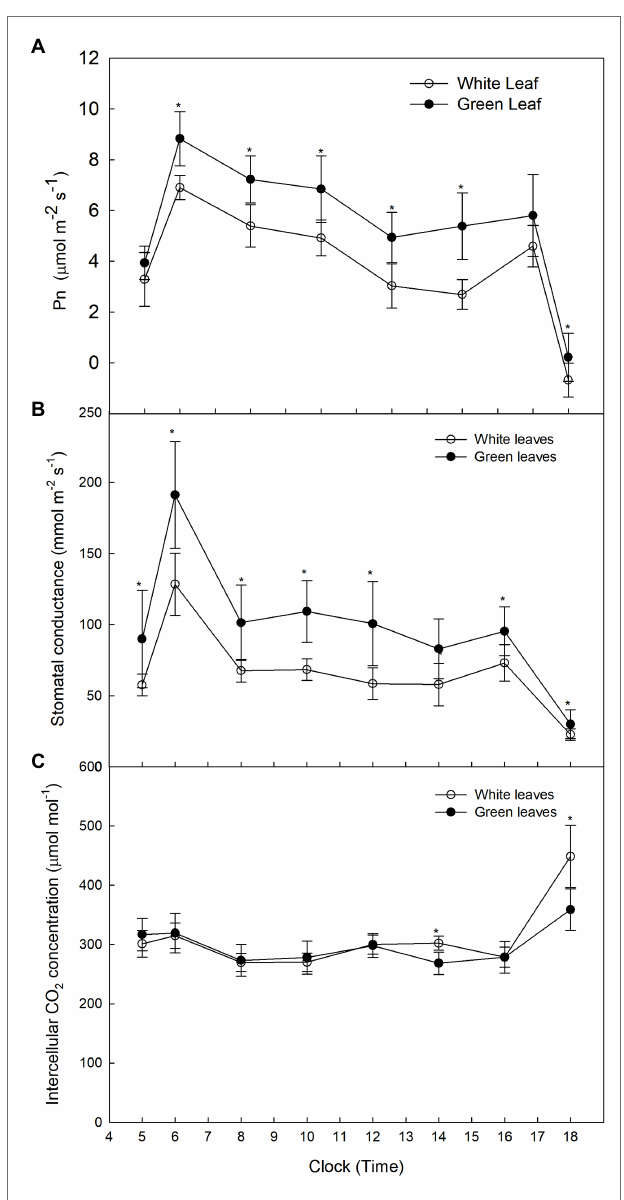
FIGURE 2 | Diurnal variation of P n in A. kolomikta green leaves and white leaves C: Diurnal variation of P n (A) , Diurnal variation of G S (B) , and Diurnal variation of C i (C)